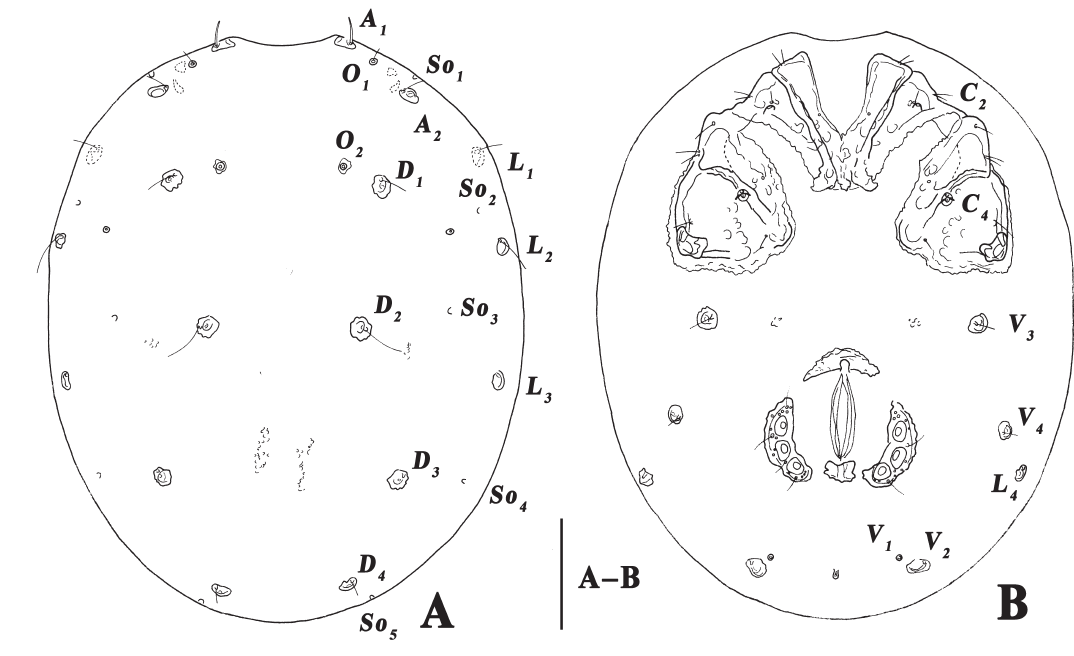
Fig. 7. Atractides ( Atractides ) menyuanensis Zhang, Li & Guo sp. nov., paratype, ♀ (GUGC, Slide No. QH-HY-2020072902). A . Idiosoma, dorsal view. B . Idiosoma, ventral view. Scale bars = 100